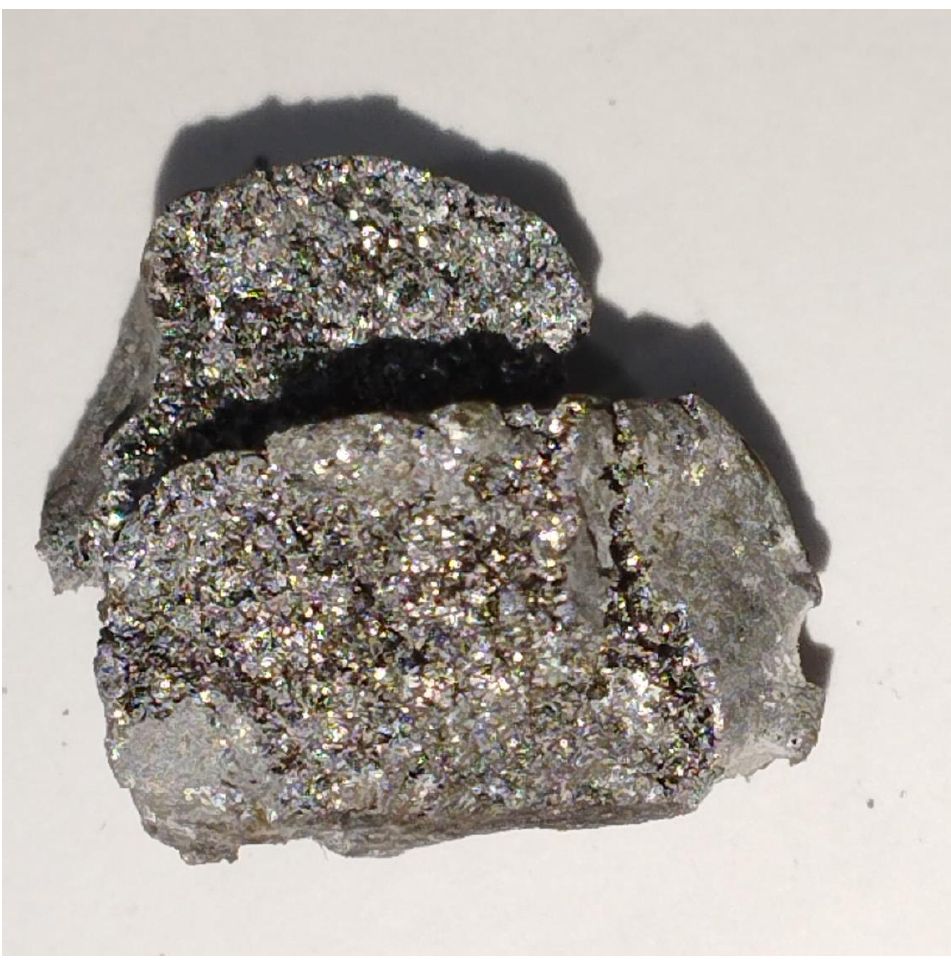
Figure 5. Aluminum boride alloy.